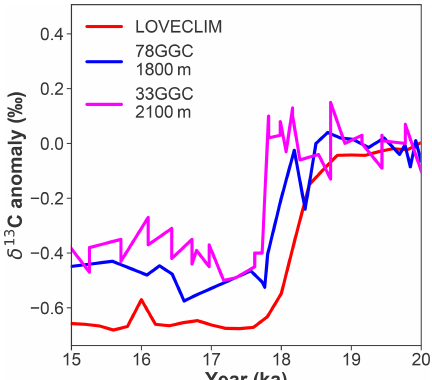
Figure 10. Observed δ 13 C anomaly of 78GGC and 33GGC from the mid-depth of the Brazil Margin at 27 ◦ S (Lund et al., 2015) and the LOVECLIM-simulated δ 13 C anomaly at this